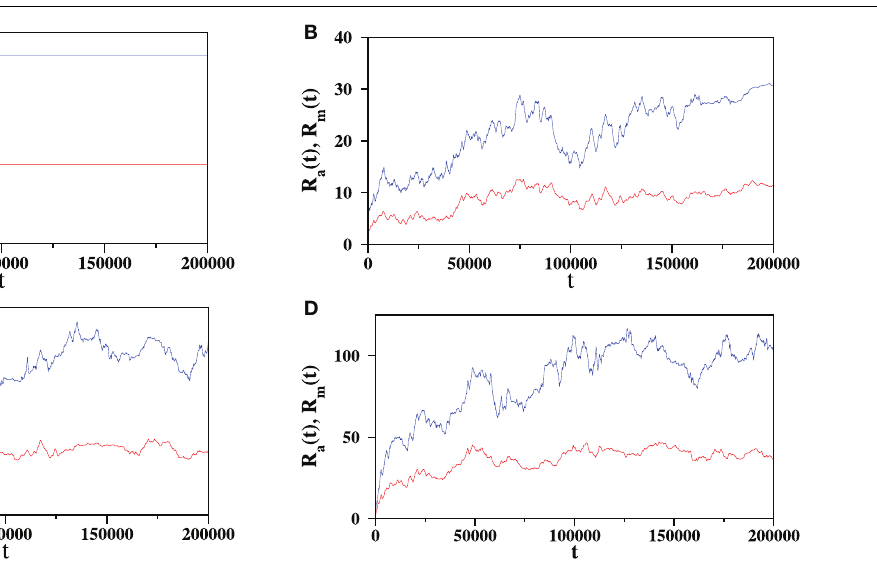
FIGURE 8 | Effect of noise is exhibited on a single flock ( N = 512 agents, each having n = 10 neighbors) which goes to a single sink state without any noise. Variation of the maximal radius R m (blue) and the average radius